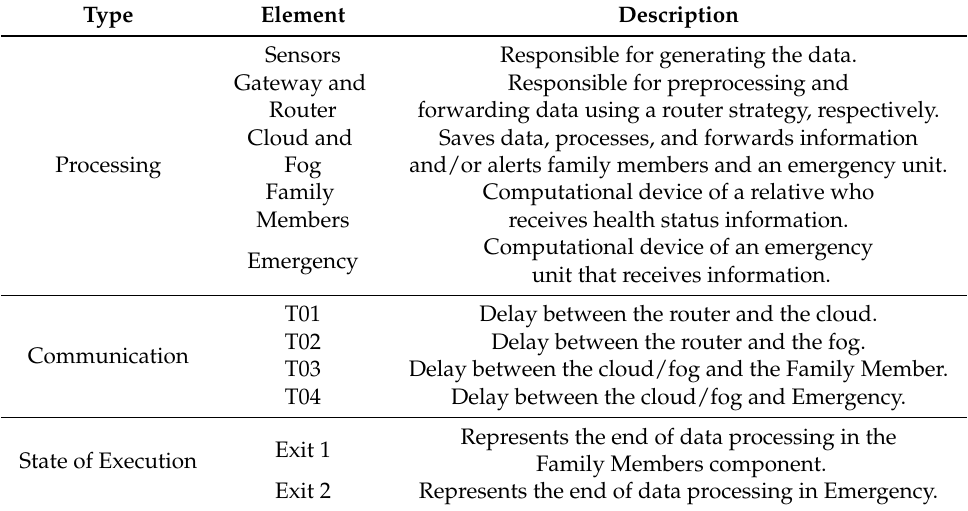
Figure 2. Analytical model to assess a health monitoring scenario. Table 1. Description of the model